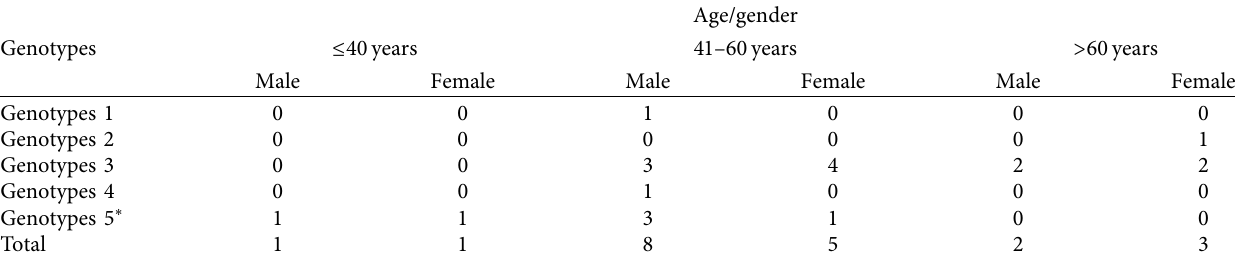
Table 4: Genotypic frequency of A. baumannii according to age groups and gender.